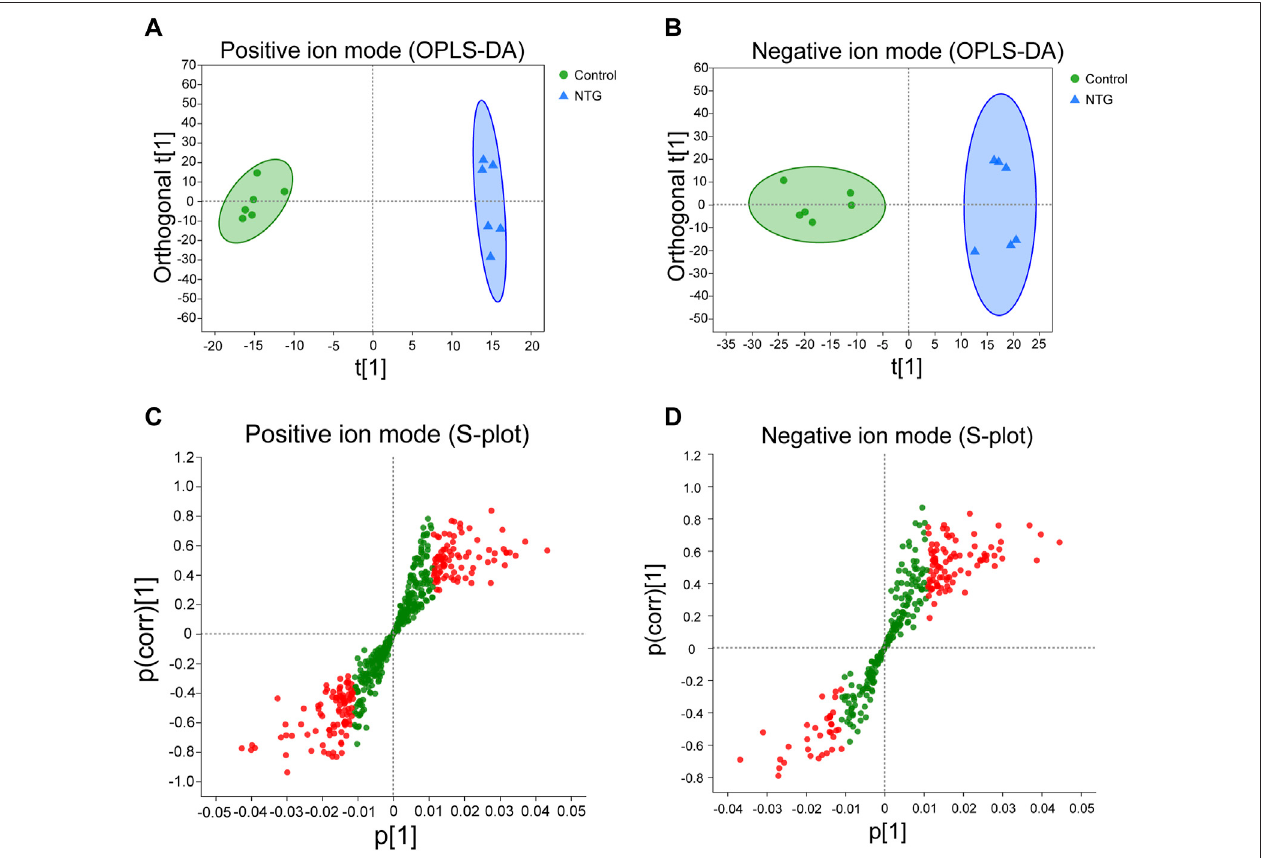
FIGURE 4 | Orthogonal partial least squares discriminate analysis (OPLS-DA) score plots and the corresponding S -plots based on the UHPLC-Q-extractive MS data of control and NTG groups in the positive (A,C) and negative ion modes (B,D) . Red dot represents the differentially expressed metabolites with VIP > 1 and p <